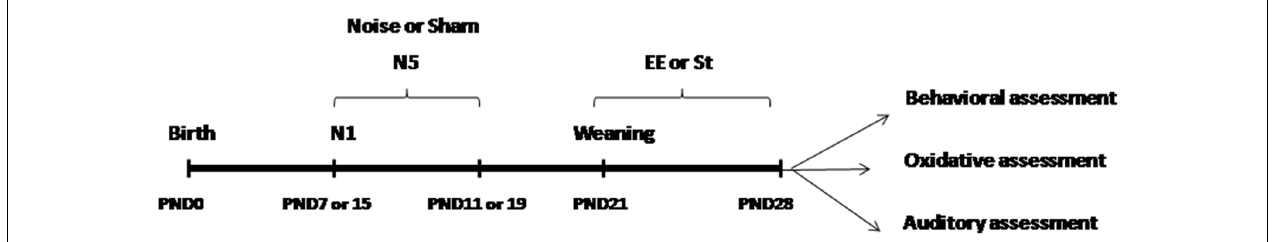
FIGURE 1 | Experimental design. Sham: non-exposed animals; N1: single noise exposure; N5: five-daily noise exposure. St: standard housing. EE: enriched environment.